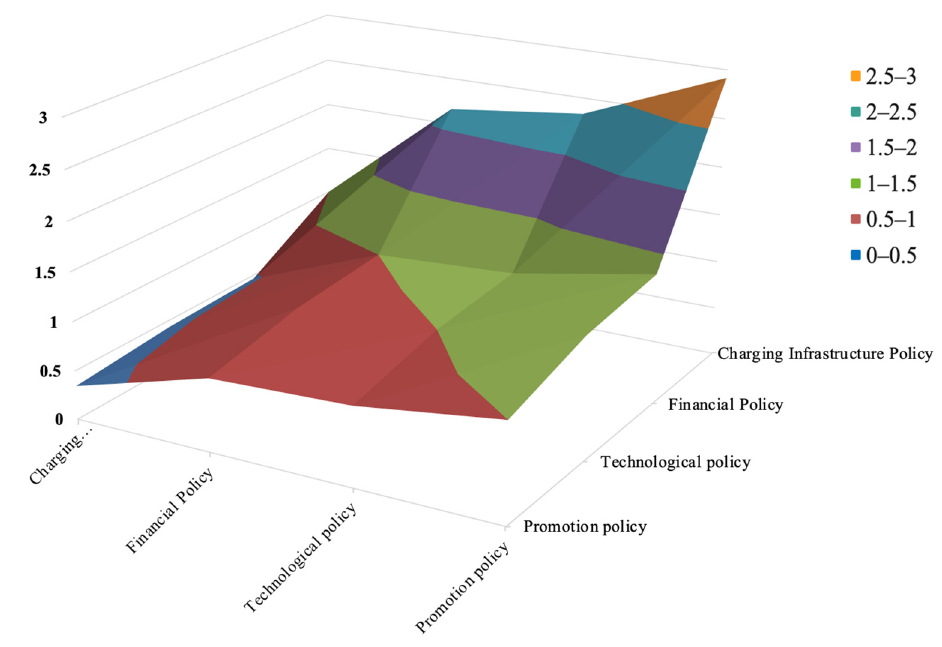
Figure 6. The comparison matrix of policy intensity.